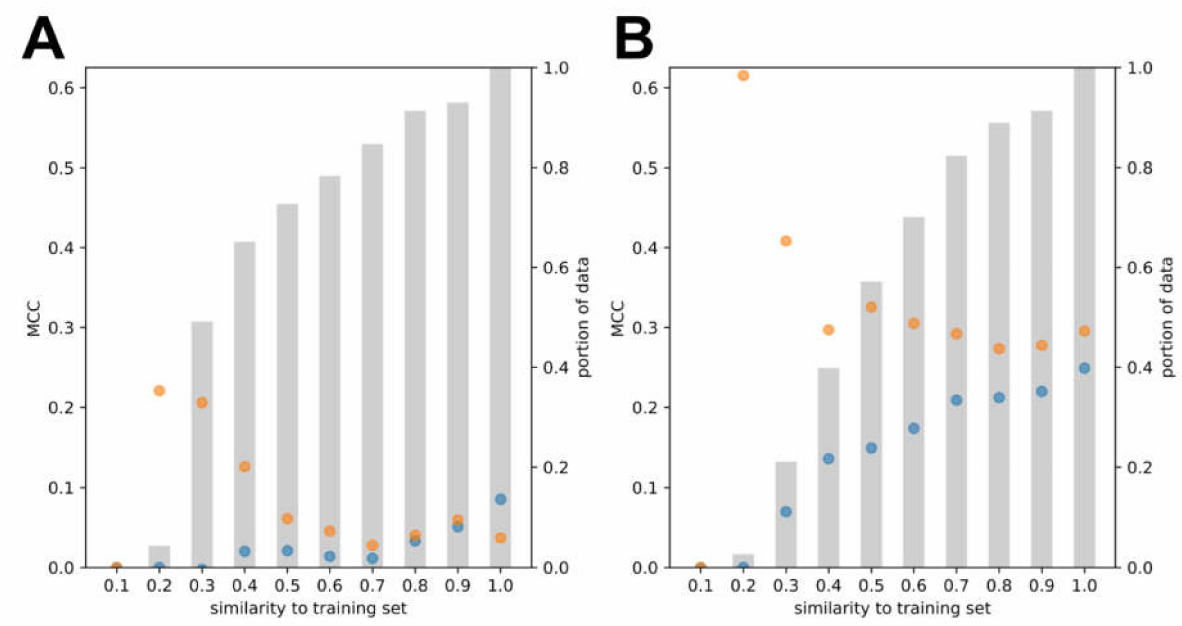
Figure 5. Performance of the regularized model (orange) and the baseline model (blue) as a function of the maximum similarity of the test molecules to the compounds in the training set, for ( A ) the ToxCast PXR data set and ( B ) the literature PXR data set. The percentage of compounds of the full test data set (computed as subset size/test set size) is visualized with gray bars.